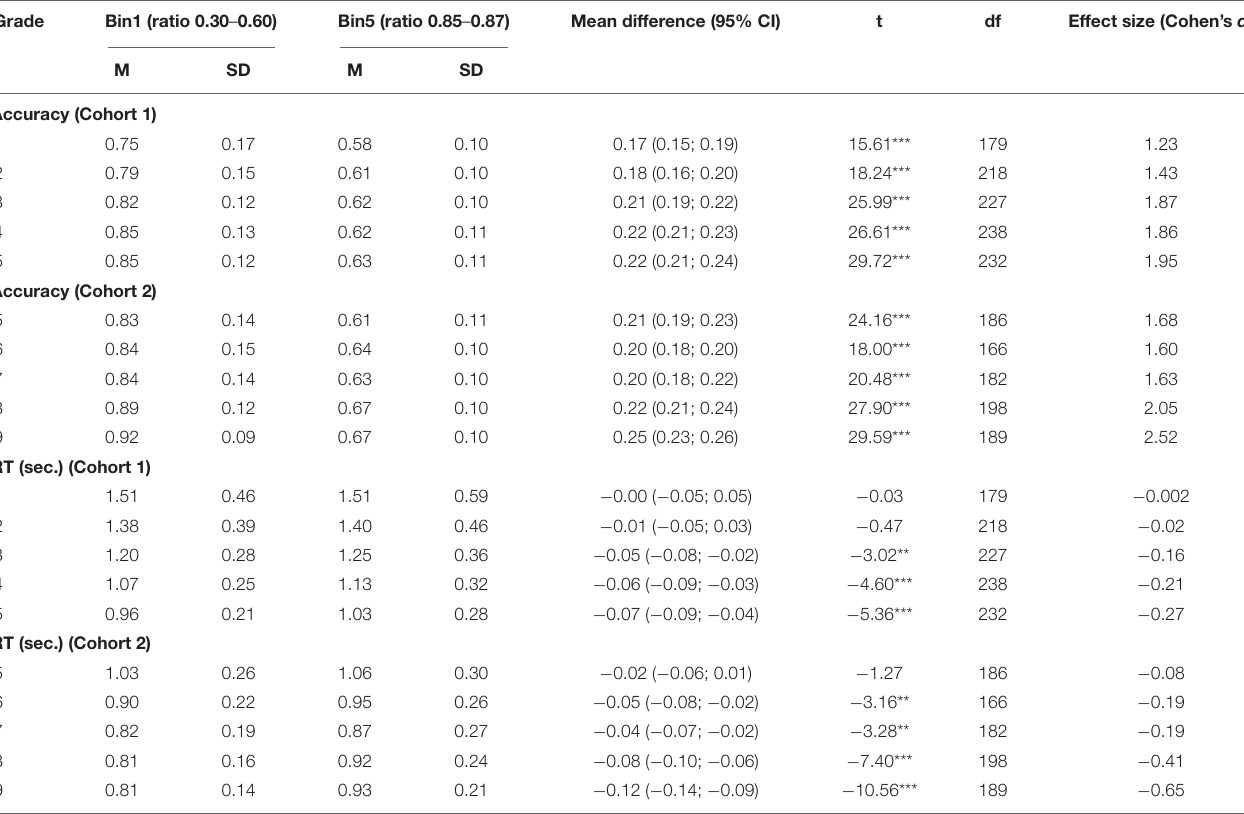
TABLE 3 | Results of paired-sample t -test for differences in ANS accuracy and RT between the smallest and the largest ratio bins. Grade Bin1 (ratio 0.30 –